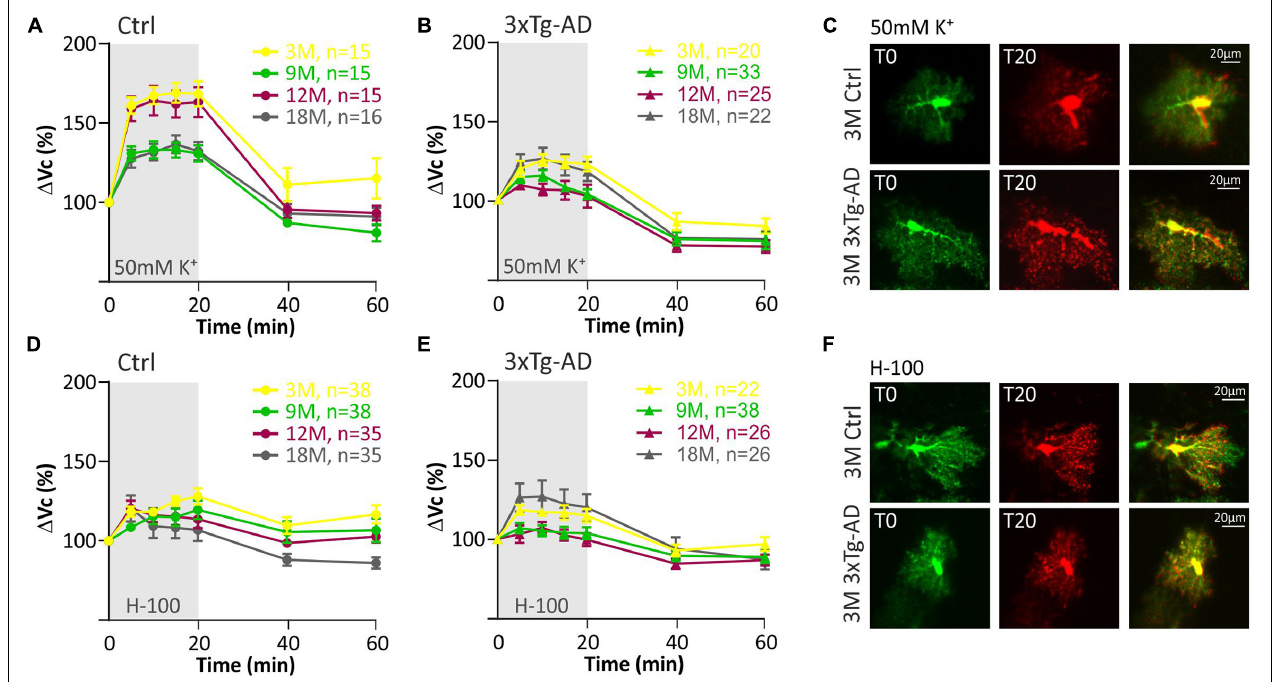
FIGURE 5 | Swelling of hippocampal astrocytes in response to severe hyperkalemia (50 mM K + ) or hypo-osmotic stress in aging controls and 3xTg-AD mice. (A,B) Time course of the total volume changes ( (cid:49) Vc) in EGFP-positive cells during a 20-min application of aCSF K + and a 40-min washout. Note that in controls (left) the astrocyte swelling is comparable in 3M- and 12M- and in 9M- and 18M-old animals. No such age-related changes were observed in 3xTg-AD mice (right). (C) Representative images of EGFP-expressing astrocytes before (T0, red) and after the 20-minute exposure to 50 mM K + (T20, green). Overlays show merged images of cells with their initial volume (red) and swollen cells (green). Green area represents swelling induced by 50 mM K + . (D,E) Time course of the total volume changes ( (cid:49) Vc) in EGFP-positive cells during a 20-min application of aCSF H − 100 and a 40-min washout. Note that no changes were observed between age groups in either controls or 3xTg-AD. (F) Representative images of EGFP-expressing astrocytes before (T0, red) and after the 20-min exposure to H-100 (T20, green). Overlays show merged images of cells with their initial volume (red) and swollen cells (green). Green area represents swelling induced by H-100. Data are presented as mean ± SEM. Statistical significance was determined by two-way ANOVA test with Tukey’s post hoc test. Ctrl, control; 3xTg-AD, triple transgenic model of AD crossbred with GFAP/EGFP mice; GFAP, glial fibrillary acidic protein; EGFP, enhanced green fluorescent protein; aCSF, artificial cerebrospinal fluid; H-100,